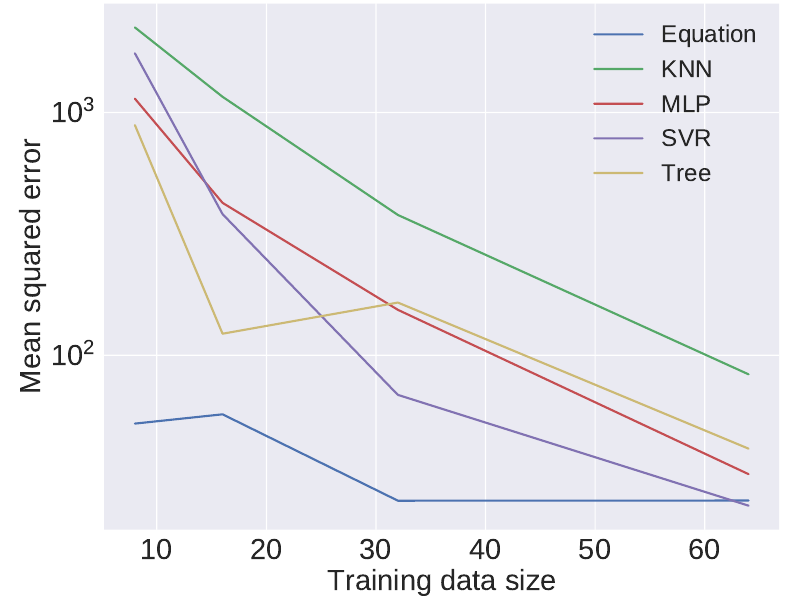
Figure 2. Average of the mean squared error for all applications of our study case Section